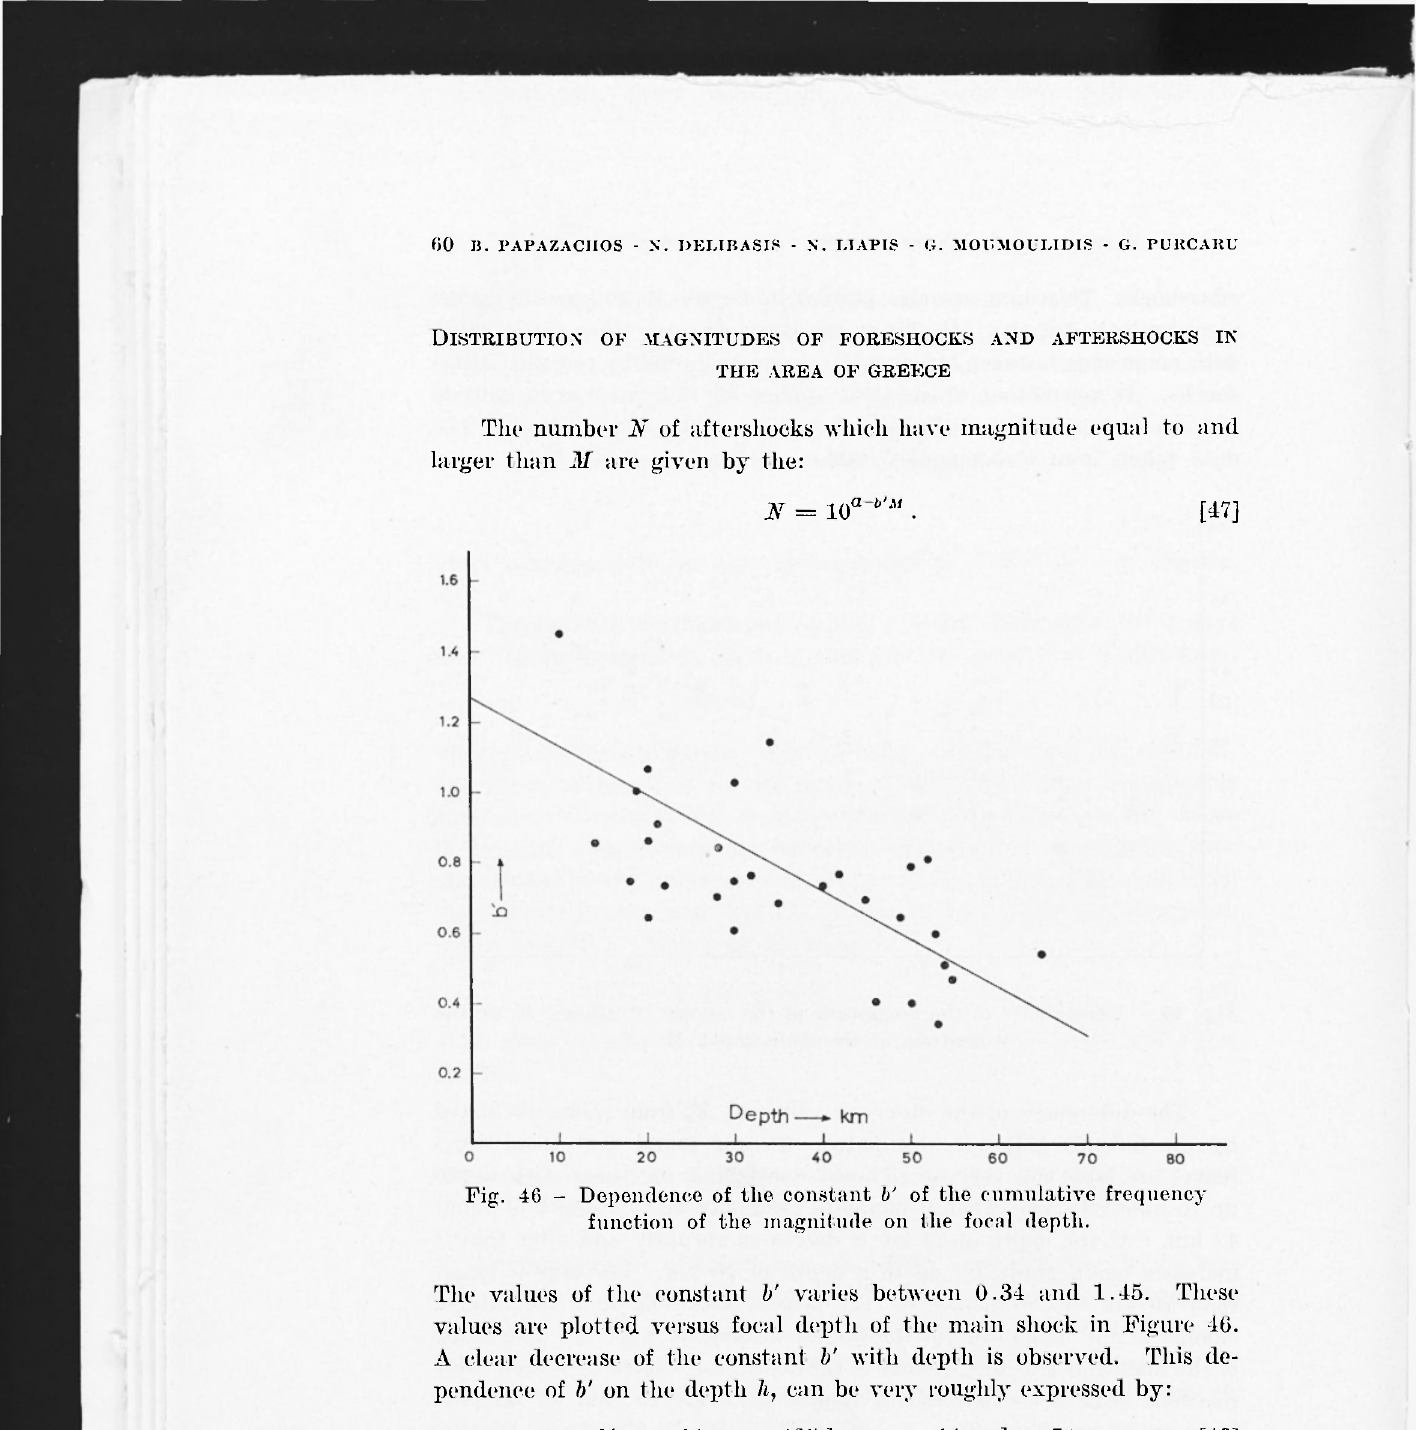
Fig. 46 - Dependence of the constant b' of the cumulative frequency function of the magnitude on the focal